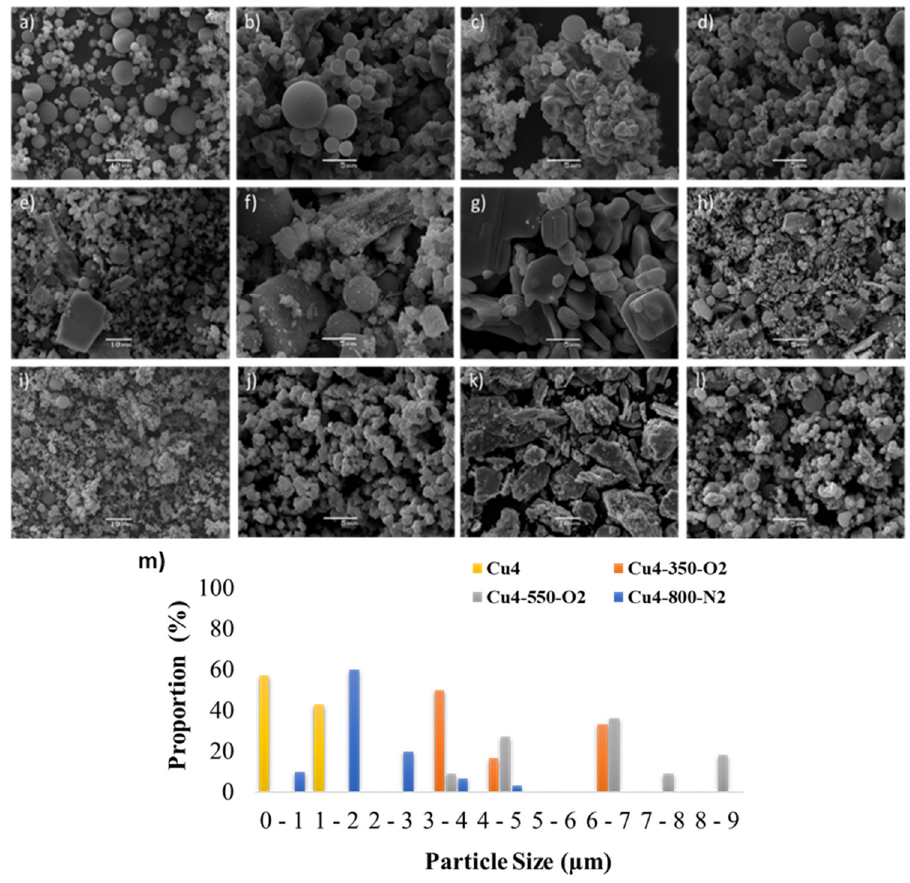
Figure 1. Scanning electron microscopy images. ( a ) Cu4; ( b ) Cu4-350-O 2 ; ( c ) Cu4-550-O 2 ; ( d ) Cu4- 800-N 2 ; ( e ) Mo4; ( f ) Mo4-350-O 2 ; ( g ) Mo4-550-O 2 ; ( h ) Mo4-800-N 2 ; ( i ) Cu4Mo4; ( j ) Cu4Mo4-350-O 2 ; ( k ) Cu4Mo4-550-O 2 ; ( l ) Cu4Mo4-800-N 2 . ( m ) Histogram for the Cu-based catalysts.